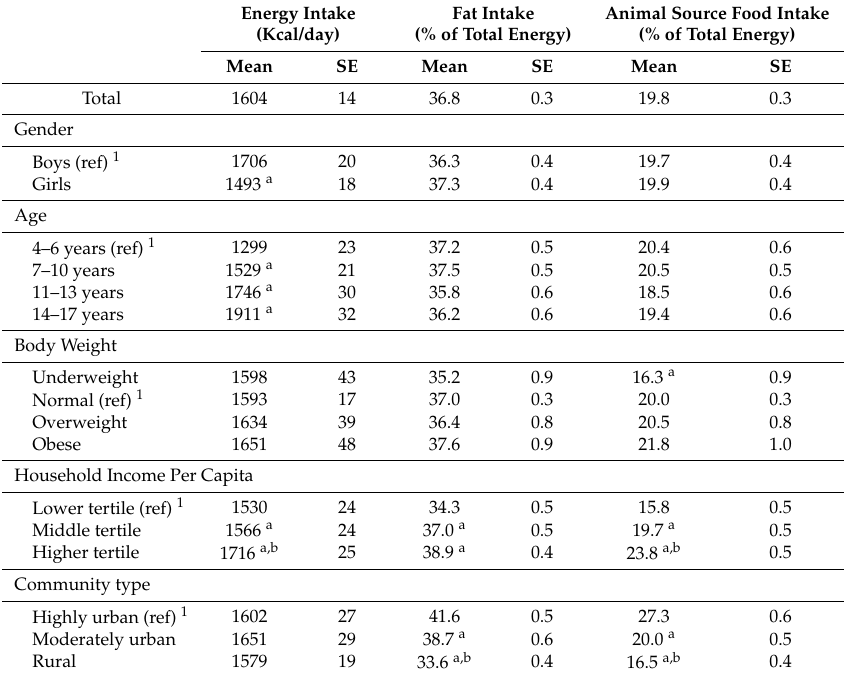
Table 2. Daily energy intake and energy sources from fat and animal source foods, CHNS 2011. Energy Intake Fat Intake Animal Source Food Intake (Kcal/day) (% of Total Energy) (% of Total Energy) Mean SE Mean SE